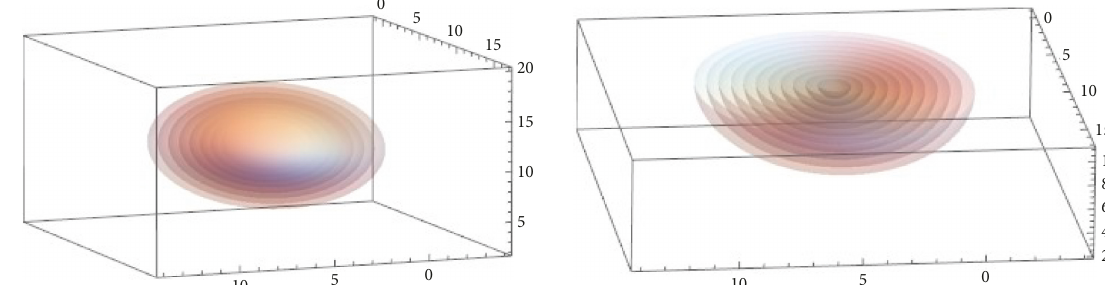
Figure 7: A + B, ( A + B )